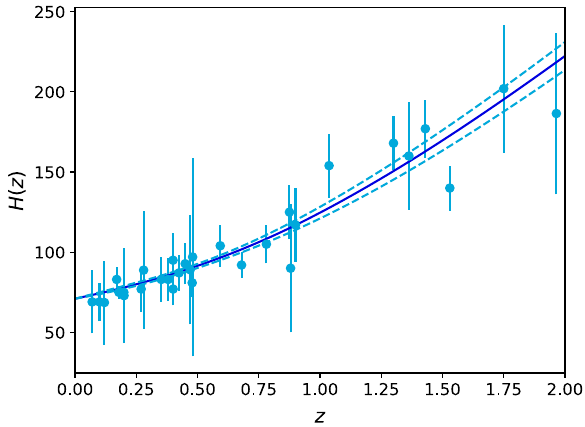
Fig. 3 Fit to OHD (left panel) and the reconstructed q ( z ) (right panel) using the joint analysis (CC+Pantheon) constraints. The dashed and red shadow regions show the 1 σ confidence limits estimated from a